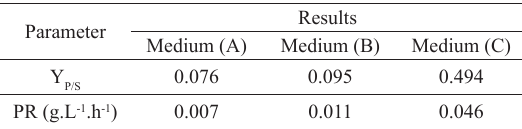
Table 2. Results of the kinetic parameters of the culture media evaluated.